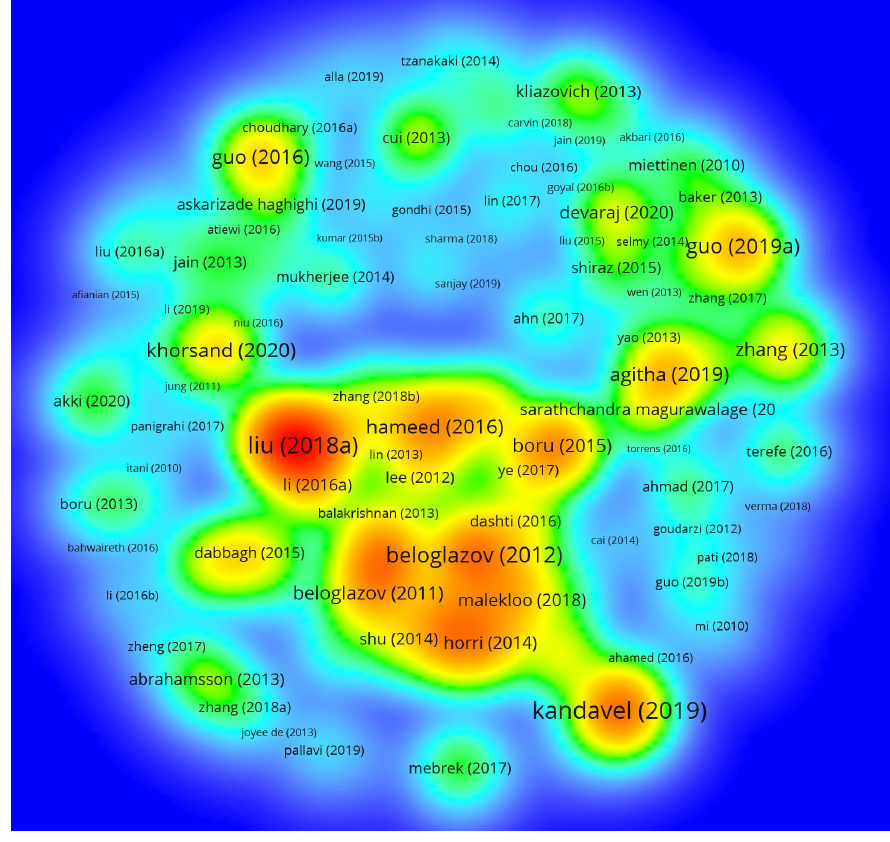
Figure 2. Direct citation analysis of the cloud computing energy efficiency research field (item density visualization; weights—normalized citations). Source: authors’ own study. Data sourced from Scopus, analyzed with VOSviewer (5 September 2020). Table 3. Top 20 core references in the cloud computing energy efficiency research field (ranked by the normalized number of citations).